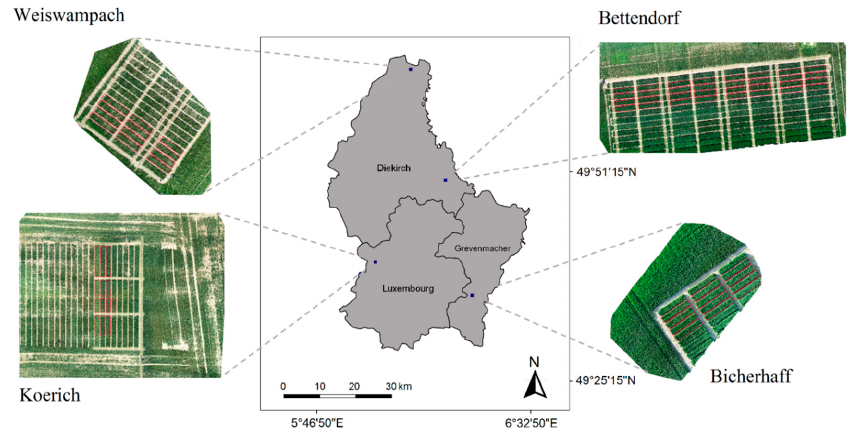
Figure 1. Distribution of experimental plots (red boundaries) within four winter wheat sites in the Grand-Duchy of Luxembourg. Figures correspond to the Red-Green-Blue (RGB) orthomosaic captured by the unmanned aerial vehicle on 24 May 2019.